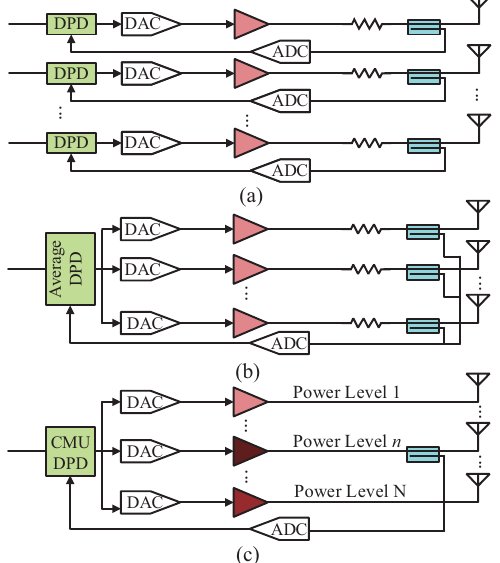
Figure 1. Block diagram of digital pre-distortion (DPD) techniques used for non-uniform amplitude excitation active antenna arrays: ( a ) one-to-one DPD [5], ( b ) average DPD [10], and ( c ) the proposed cross-mode universal digital pre-distortion